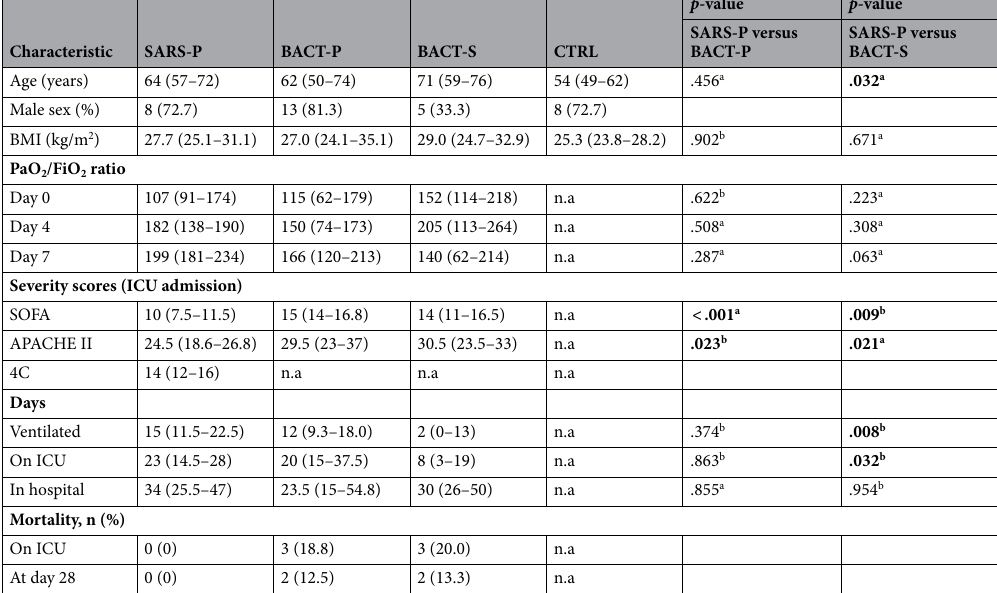
Table 1. Demographic characterization of patients with SARS-CoV-2 pneumonia (SARS-P, n = 12), bacterial pneumonia (BACT-P, n = 16), bacterial sepsis with origin other than pneumonia (BACT-S, n = 15) and of healthy control subjects (CTRL, n = 11). Significant values are in [bold]. SOFA Sequential Organ Failure Assessment, APACHE II Acute Physiology And Chronic Health Evaluation II, 4C Coronavirus Clinical Characterisation Consortium-Mortality Score. Values are median (IQR). a two-tailed unpaired Student’s t -test, b Mann–Whitney- U